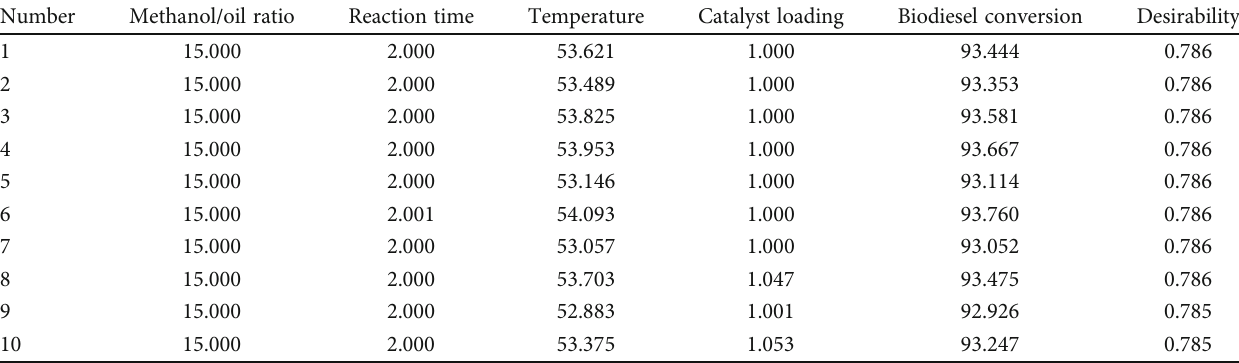
Table 7: Optimization results by Design-Expert.